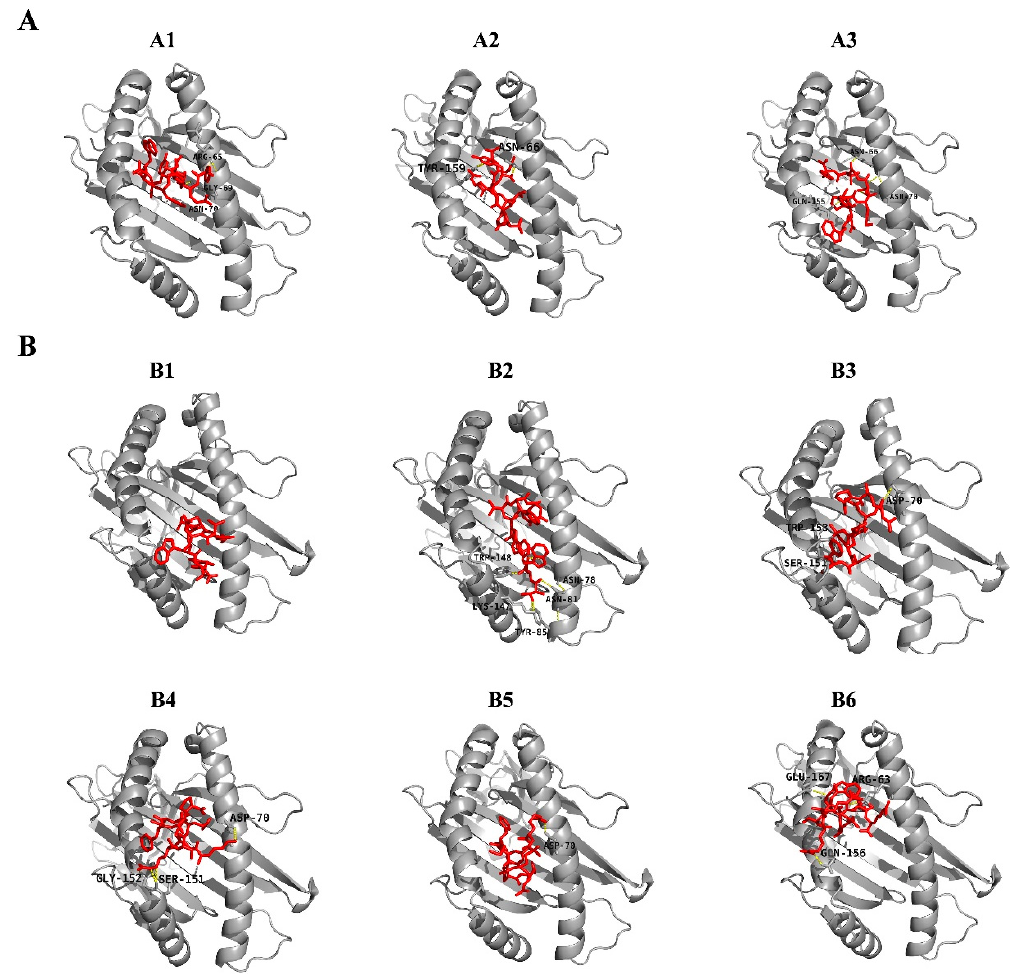
Figure 5. Molecular interaction analysis of PPV7 peptides (shown as red) to SLA-2*0402 ( A ) and SLA-3*0401 ( B ) protein (shown as gray). Interacting residues are shown and are consistent with the information in Table 4.